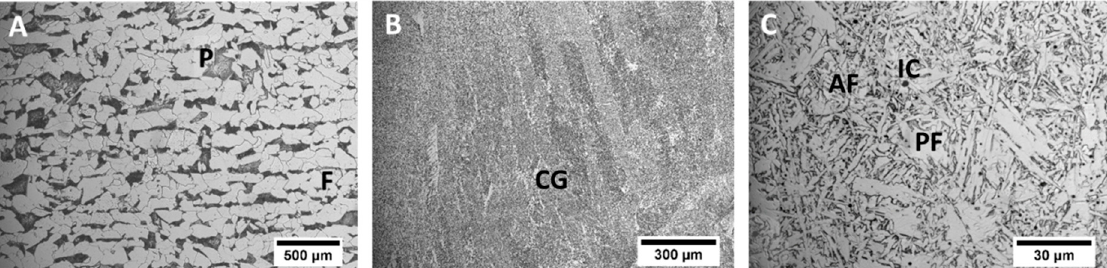
Figure 4. Microstructures of the base material ( A ), upper ( B ), and central ( C ) area of the last welding pass. P—Perlite, F—Ferrite, CG—Columnar grains, AF—Acicular ferrite, PF—Polygonal ferrite, and IC—Inclusion.